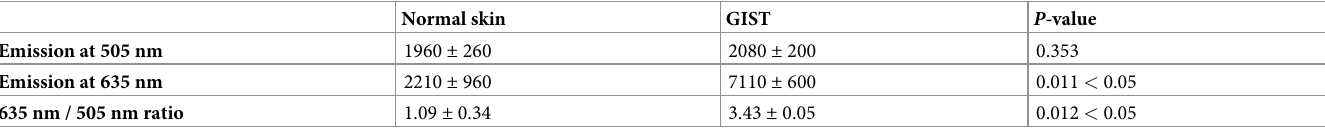
Autofluorescence in normal skin tissues and fluorescence intensity following treatment with 5-ALA in GIST and relative fluorescence intensities. The conditions were as described in the legend of Fig 5. These data were obtained from xenograft flank tumor models injected with 300 mg/kg 5-ALA after 4 h.